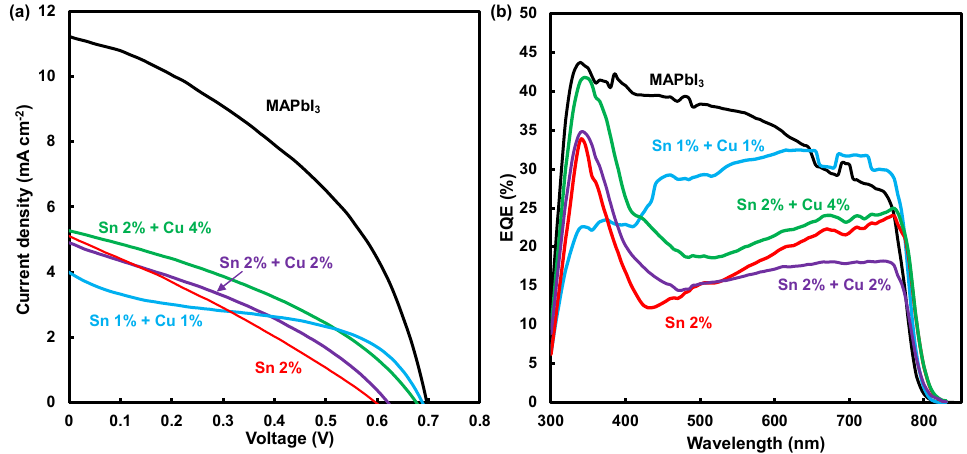
Figure 2. ( a ) J-V characteristics and ( b ) EQE of the present perovskite solar cells. Table 2. Compositions and calculated t -factors of the present MA 0.9 FA 0.1 Pb 1-x-y Sn x Cu y I 3 perovskite compounds.